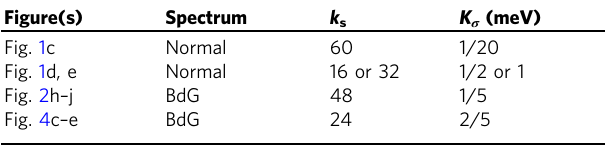
The fi gure(s) in each row ( fi rst column) either show the DOS of the normal state or a superconducting Bogoliubov de-Gennes (BdG) Hamiltonian matrix spectrum (second column). In all fi gures the DOS is plotted as a kernel density estimation from a k s × k s point sampling of the Brillouin (third column) and with a Gaussian width of K σ (last